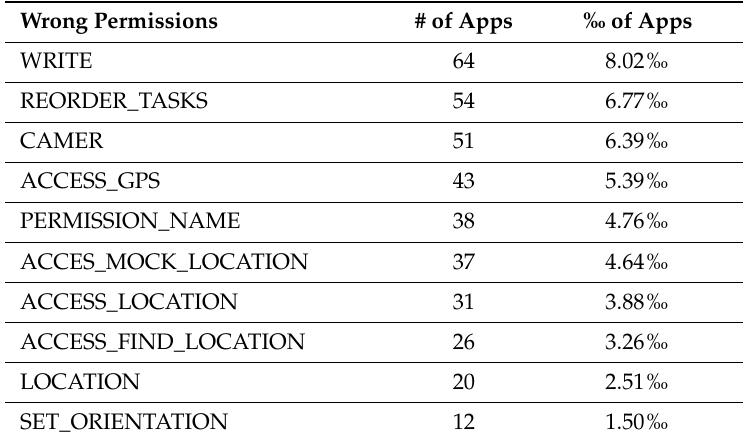
Table 2. The top 10 wrong permissions used in